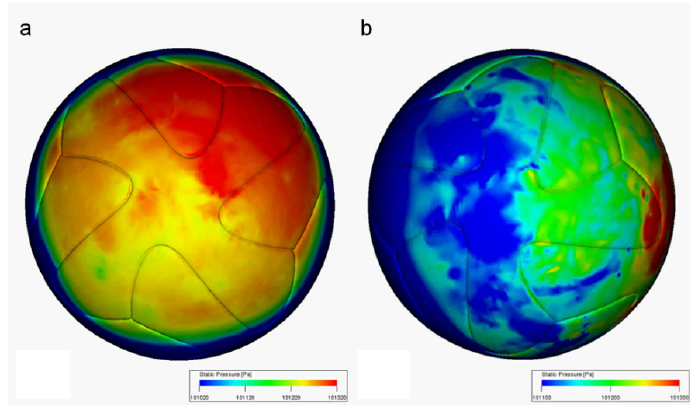
Figure 7. Example of static pressure observed on ( a ) nonspinning and ( b ) spinning soccer balls using CFD (back view). The spin direction of the spinning soccer ball in ( b ) is anticlockwise from the top view.